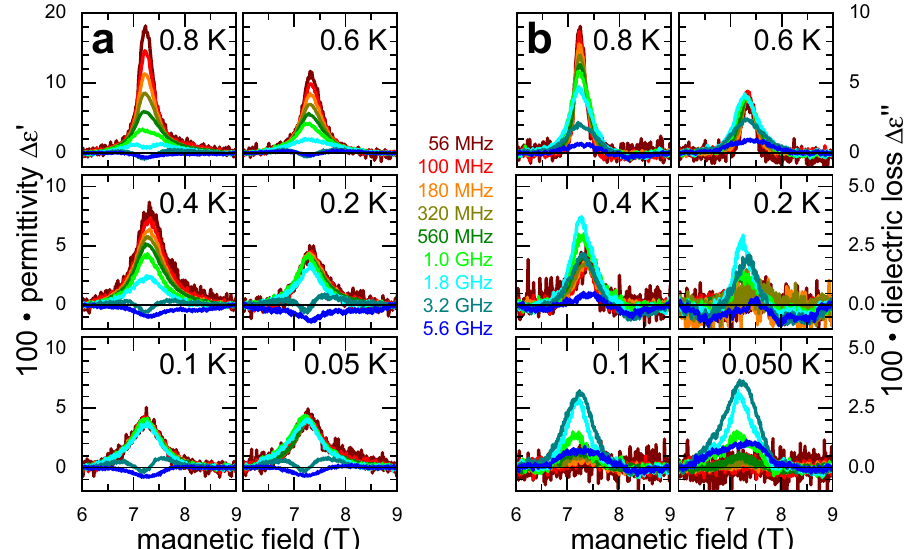
Fig. 3 Low-temperature dielectric measurements. The magnetic fi eld-dependent complex permittivity Δ ε * in the vicinity of H c for different frequencies and temperatures. In a the evolution of Δ ε 0 from a dispersive feature at a higher temperature into a peak with no dispersion up to approximately 1 GHz (green) with a steep drop above this frequency with cooling is shown. The dielectric loss Δ ε ″ in b also changes from a broad, dispersive maximum at higher temperatures observed for all frequencies to a , in the frequency domain, a narrow peak located roughly between 2 and 3 GHz at low temperature.